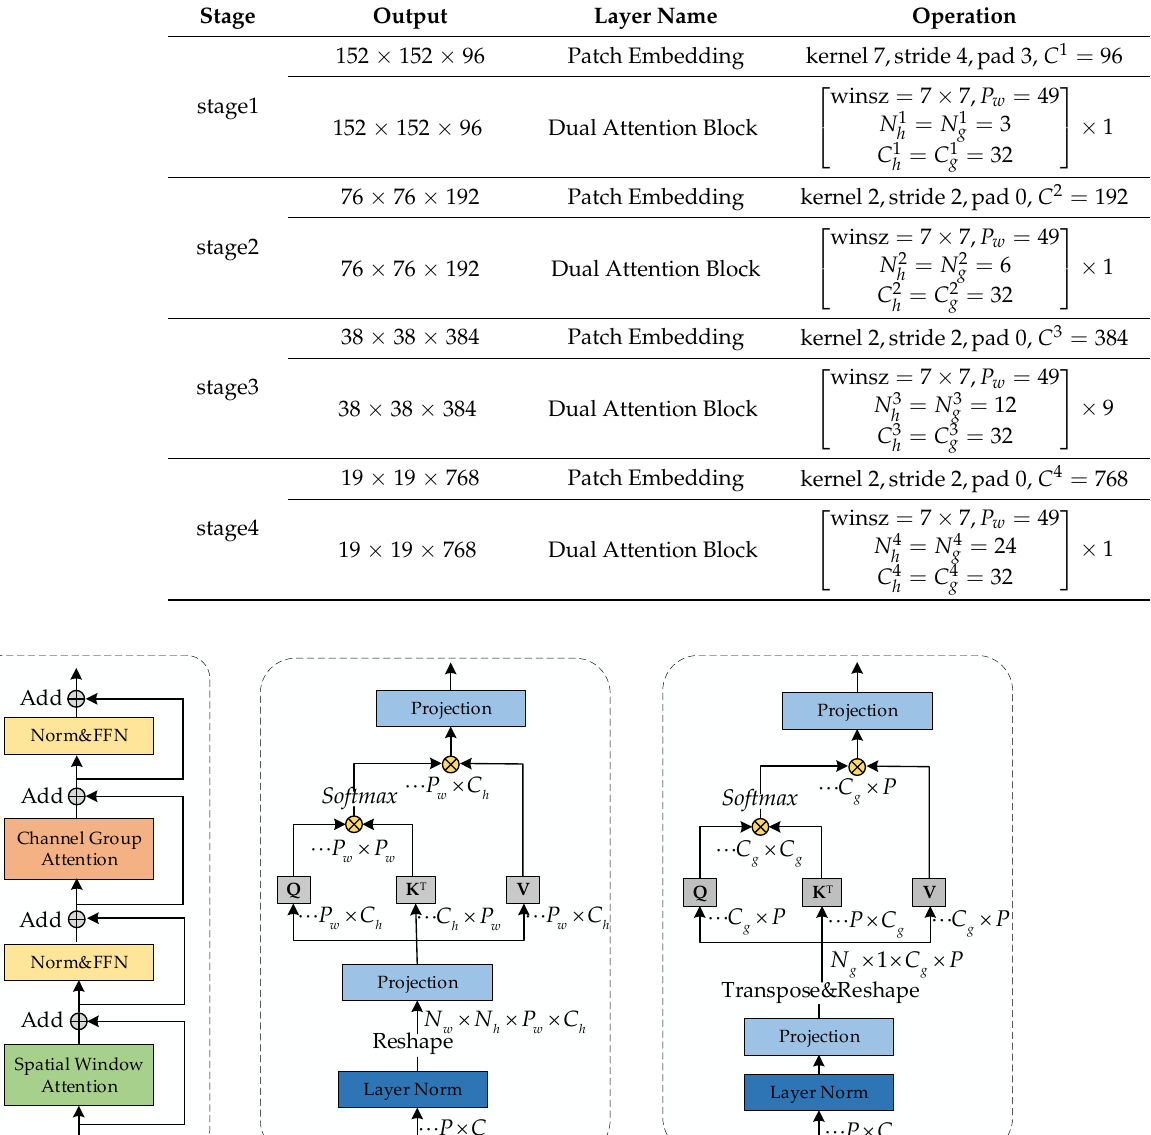
Table 1. Details about backbone network.